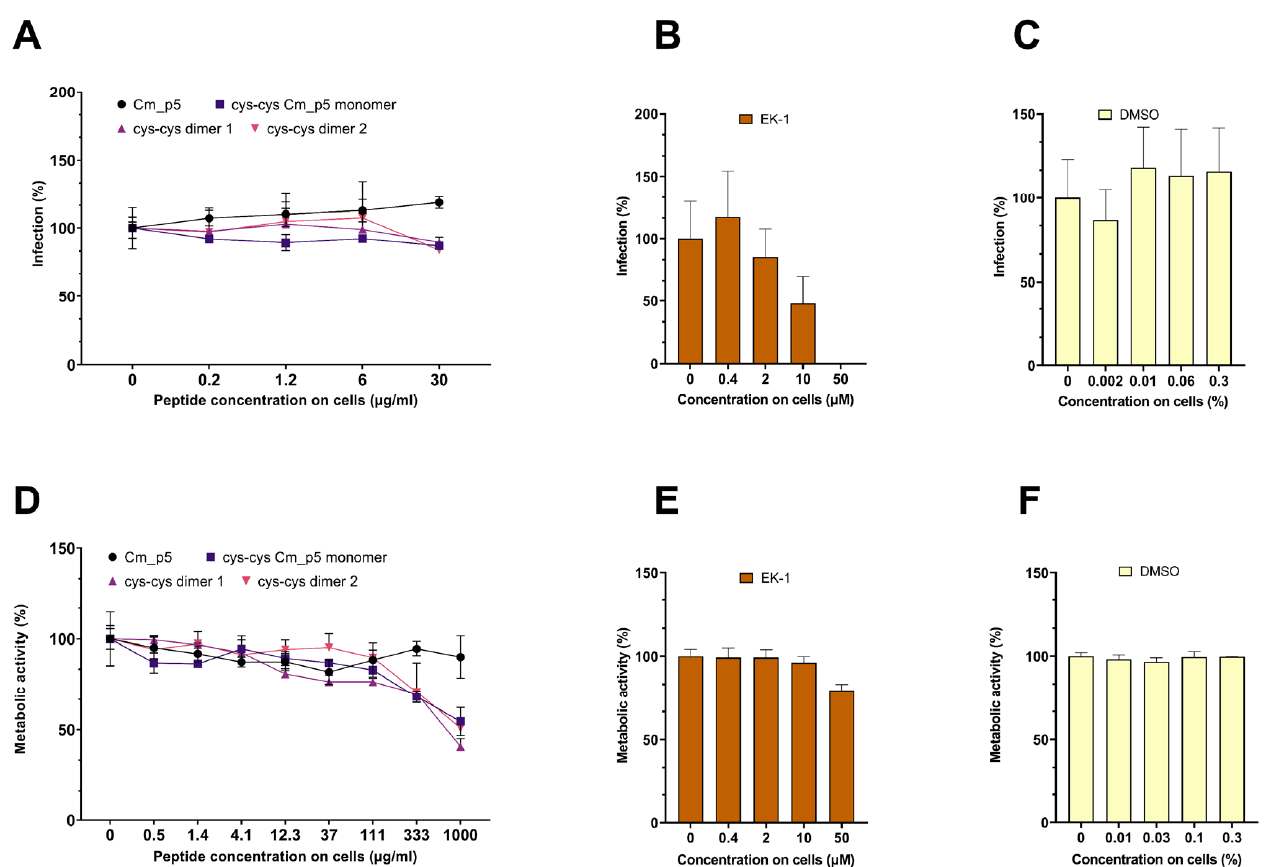
Figure 3. Effect of Cm-p5 peptides on SARS-CoV-2 pseudoparticle (PP) transduction. ( A , C ) Luciferase-encoding PP harboring the SARS-CoV-2 Spike protein were incubated with the peptides or the DMSO control for 1 h at 37 ◦ C. Thereafter, the mixtures were inoculated on Caco2 cells, resulting in the indicated concentrations of the peptides on cells. The infection rates were determined 16 h post transduction by measuring the cell-associated luciferase activity. Shown above are the mean values derived from triplicate infections ± SD (relative to controls containing no peptide, 100%). ( B ) Caco2 cells containing the indicated concentrations of the SARS-CoV-2 inhibitory peptide EK1 were inoculated with SARS-CoV-2 PP, and the infection rates were determined as described under ( A ). ( D – F ) Metabolic activity of the Caco2 cells incubated with peptides for 48 h. The metabolic activity of the cells was determined by an MTT assay ( D , F ) or CellTiter-Glo®Luminescent Cell Viability Assay ( E ). The effect of the Cm-p5 compound was measured in an independent experiment, but are shown in the same figure. Values shown are the mean values derived from triplicate measurements ± SD (relative to controls containing no peptide,